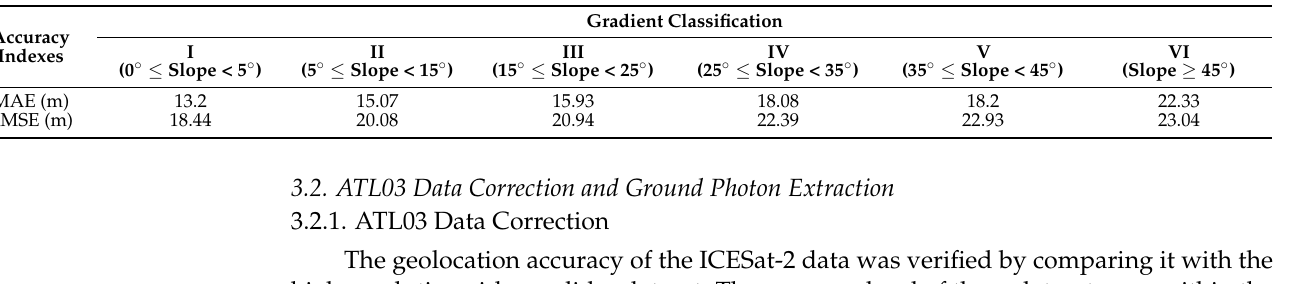
Table 2. Elevation accuracies of the extracted ICESat-2 ground photons under different terrains (classification criteria by slope of forest